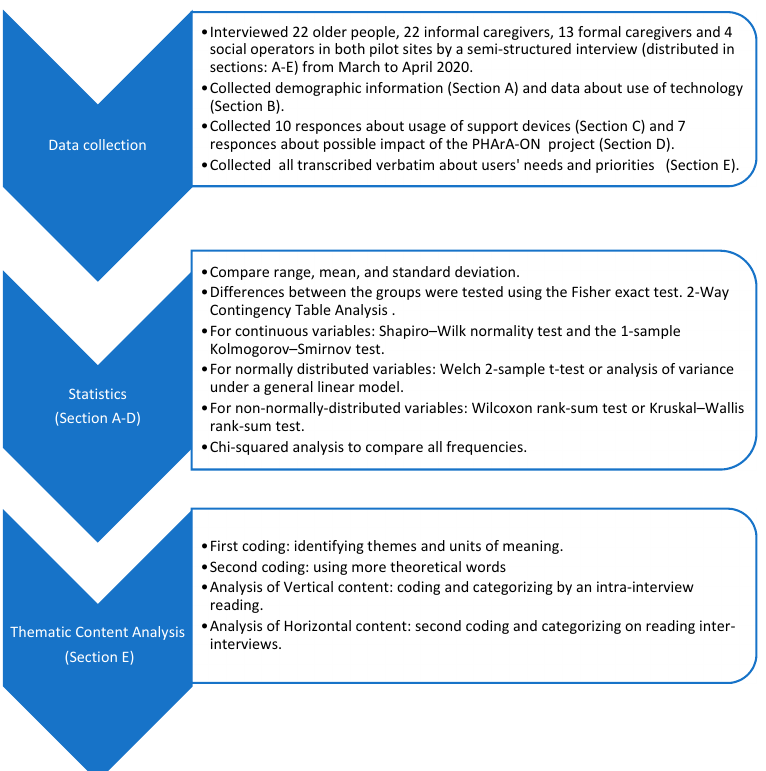
Figure 2. Flow chart regarding the analysis phases carried out.